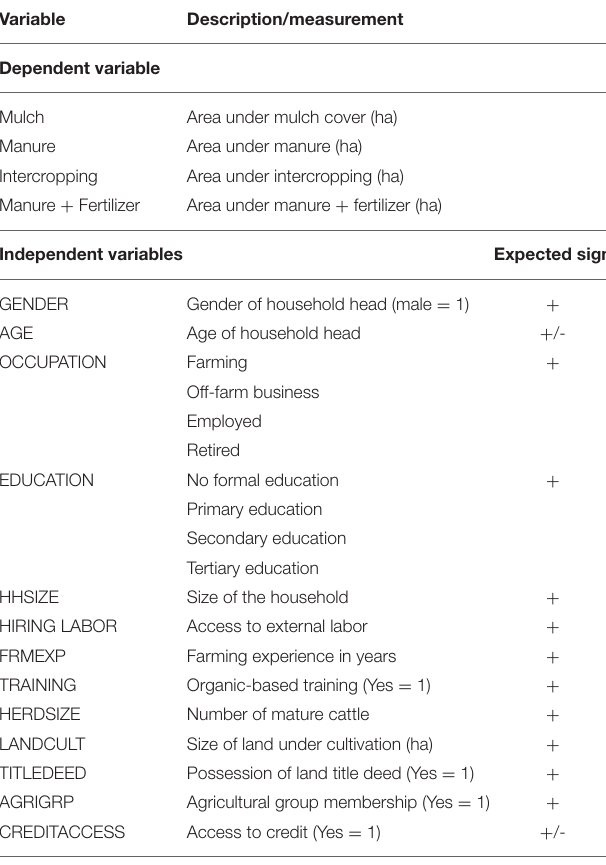
TABLE 1 | Definition of dependent and explanatory variables. TABLE 2 | Descriptive summary statistics of the sampled smallholder farmers in